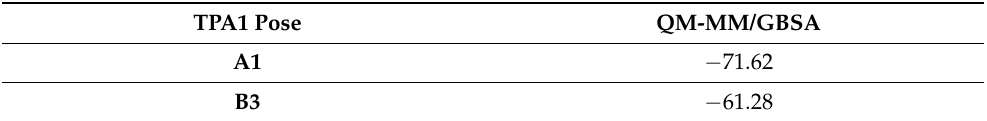
Table 3. QM/MM calculations for 5 ns of MD simulation after transformation of TPA14 in TPA1 in the B3 binding